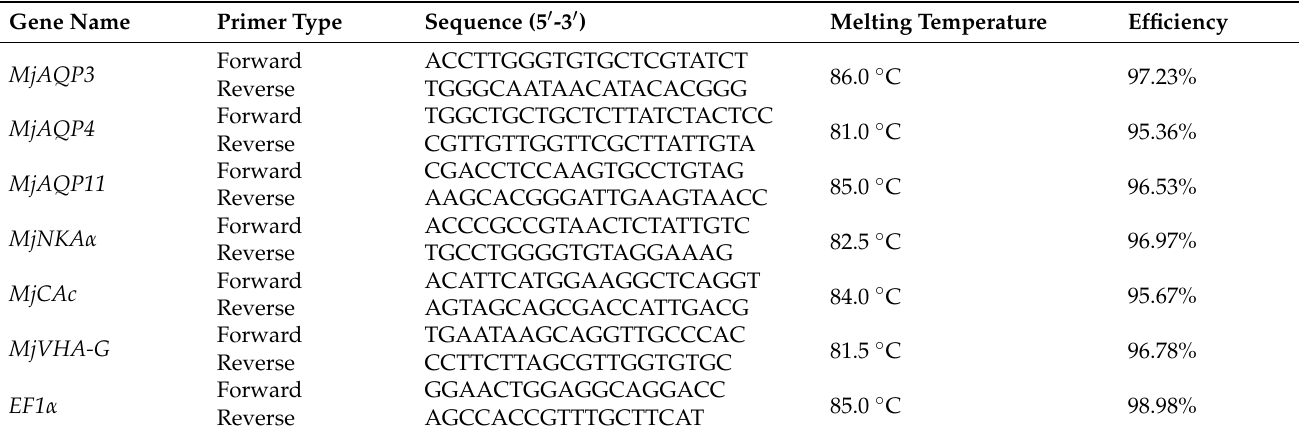
Table 2. Specific primers used for qPCR